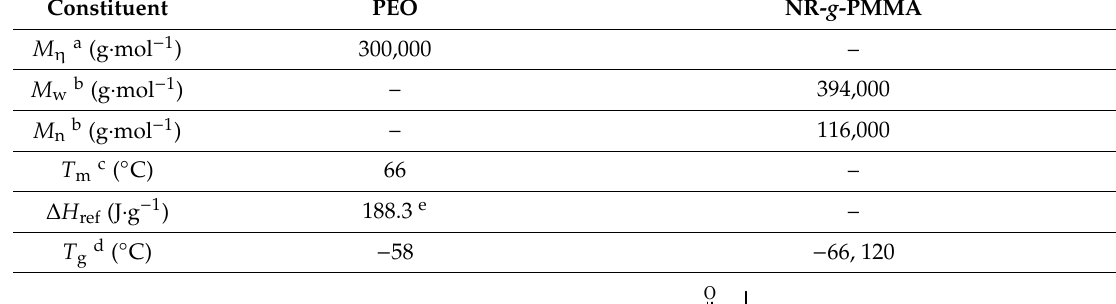
Table 1. Characteristics of poly(ethylene oxide) (PEO) and natural rubber-graft-poly(methyl methacrylate) polymer (NR- g -PMMA) used in this work.